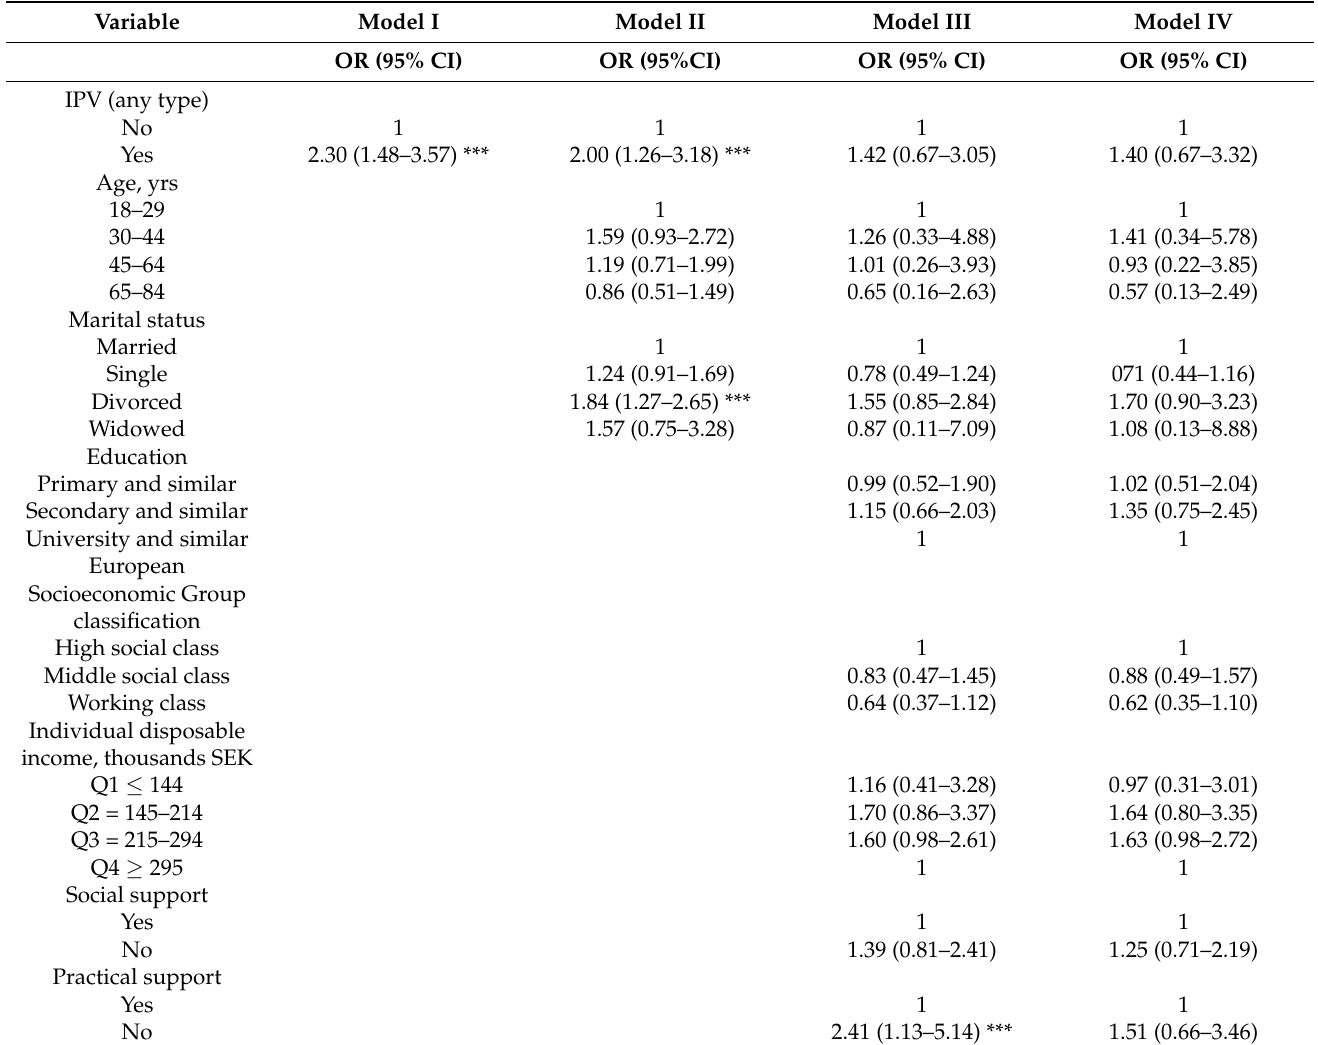
Table 4. Odds ratios (ORs) with 95% confidence intervals (CIs) for the relationship between interper- sonal violence (IPV) and depression among men, according to the Gävleborg Health on Equal Terms Survey